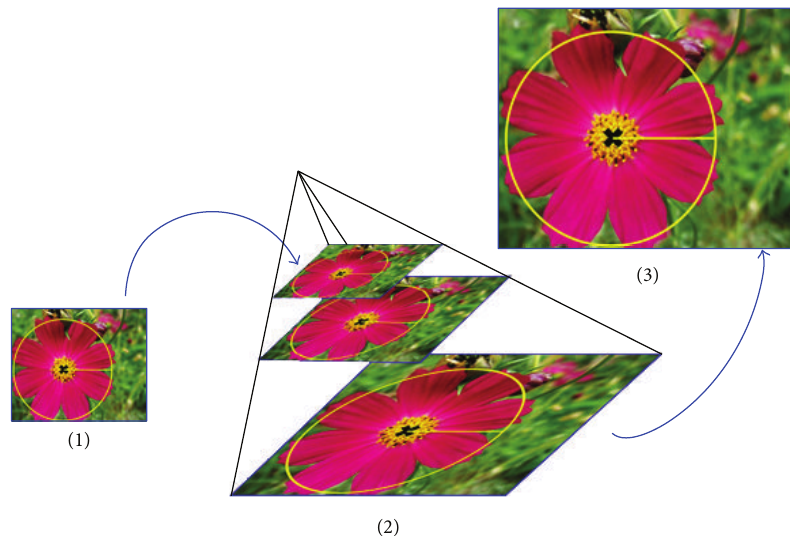
Figure 4: Multiresolution detection. (1) A full evaluating search only occurs over the lowest resolution image; (2) detected center with neighbors will be searched at higher resolution; (3) result after final search at the original